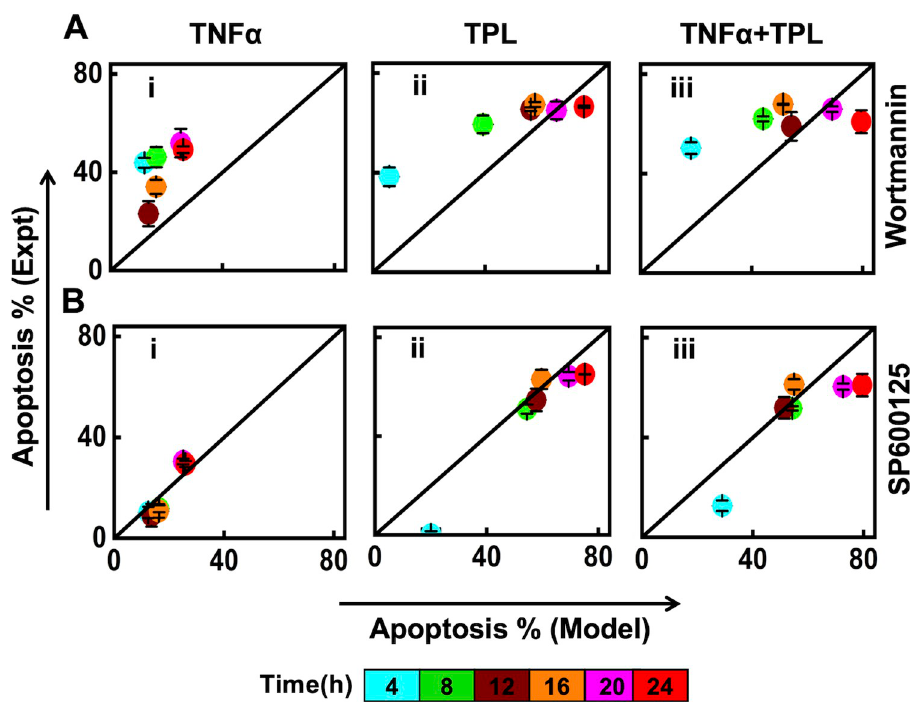
Fig 7. Comparison of experimental and model predicted apoptosis percentage under (A) Wort and (B) SP6 inhibitory conditions. (i), (ii), and (iii), respectively correspond to the predictions for TNF α , TPL, and TNF α +TPL stimulation conditions. While 5 best fit parameters were considered for model predictions, those of experiments are based on triplicates. The time points are appropriately color-coded in